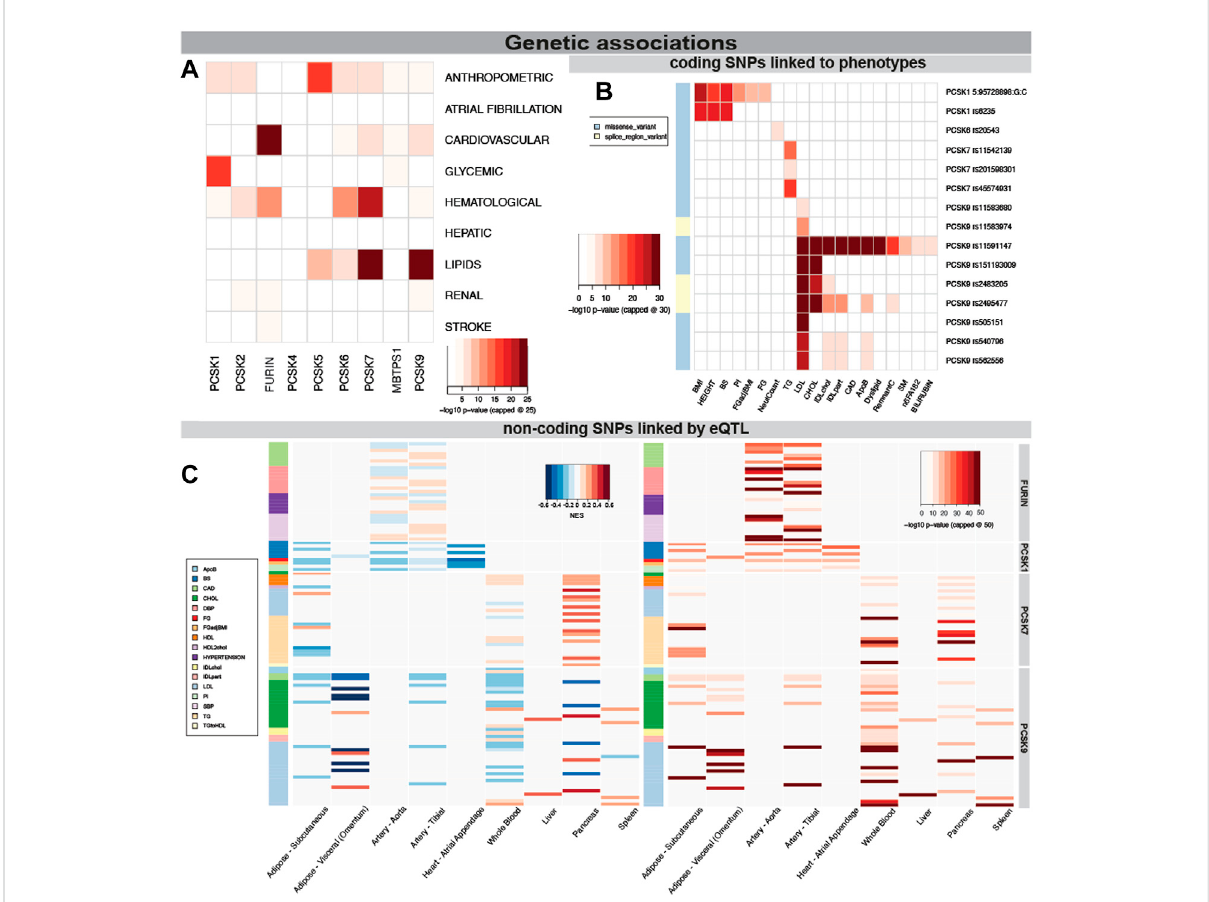
FIGURE 2 Genetic associations of PCSK family members with cardiovascular traits. PCSK gene variants analysed by MAGMA software for top CVD associated categories. The lowest p -value per disease category is shown for each member of the PCSK family, -log10 p -value was capped at 25 for clarity (A) . Associations of coding SNPs in the PCSK family linked to various cardiovascular phenotypes. -log10 p -value was capped at 30 for clarity (B) . Non-coding PCSK SNPs linked via eQTL analyses to various CVD related tissues. Heatmap on the left shows the GTEX eQTL Normalised Effect Size (NES) to indicate direction of the expression change. The heatmap on the right shows the GWAS p -value for each non-coding SNP. -log10 p -value was capped at 50 for clarity (C) . Additional individual SNP information may be found in Supplementary Table S2. Single